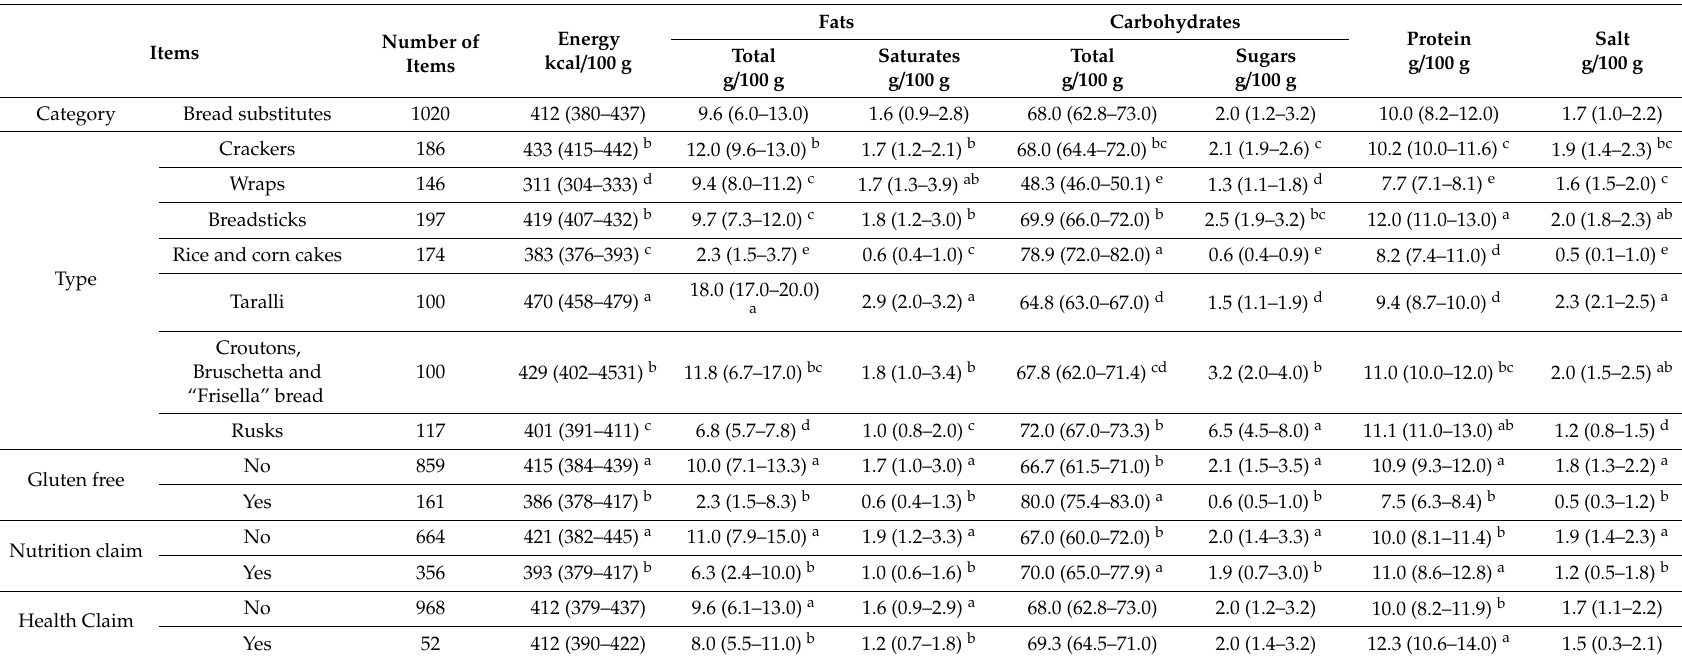
Table 2. Energy, macronutrients and salt across bread substitute